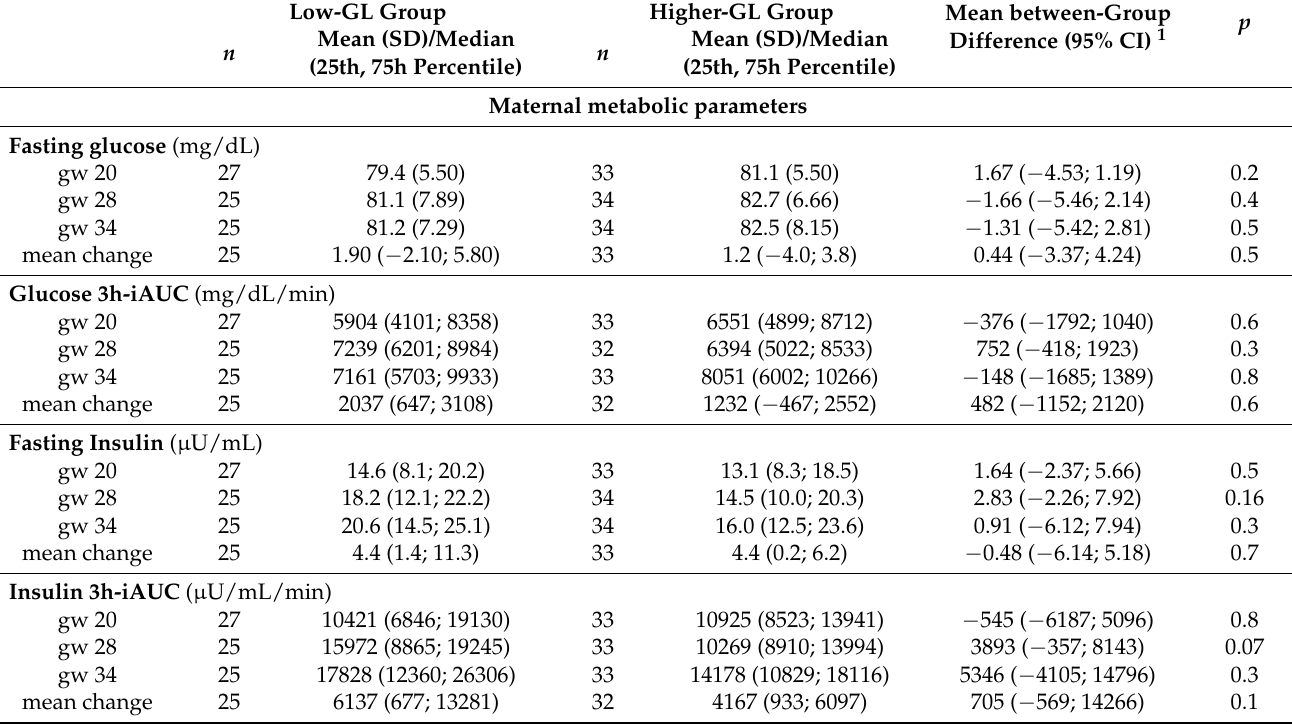
Table 3. Maternal metabolic parameters and pregnancy outcomes by dietary intervention group ( n = 62). Low-GL Group Higher-GL